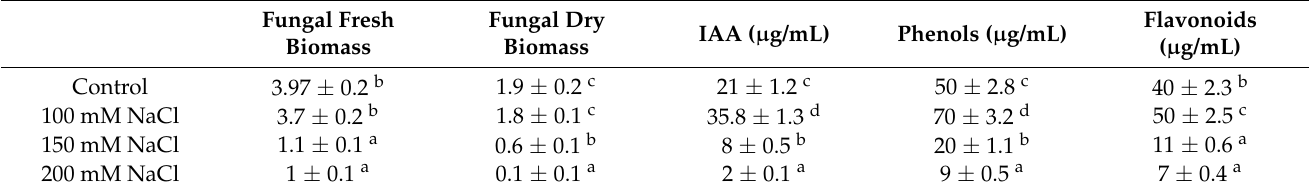
Table 1. Salt resistance of selected fungal isolate (FH15) and their effect on biomass, IAA, phenols and flavonoids content under salinity stress. The bars represent mean with ± SE and the different letters on the bars represent significance at p =